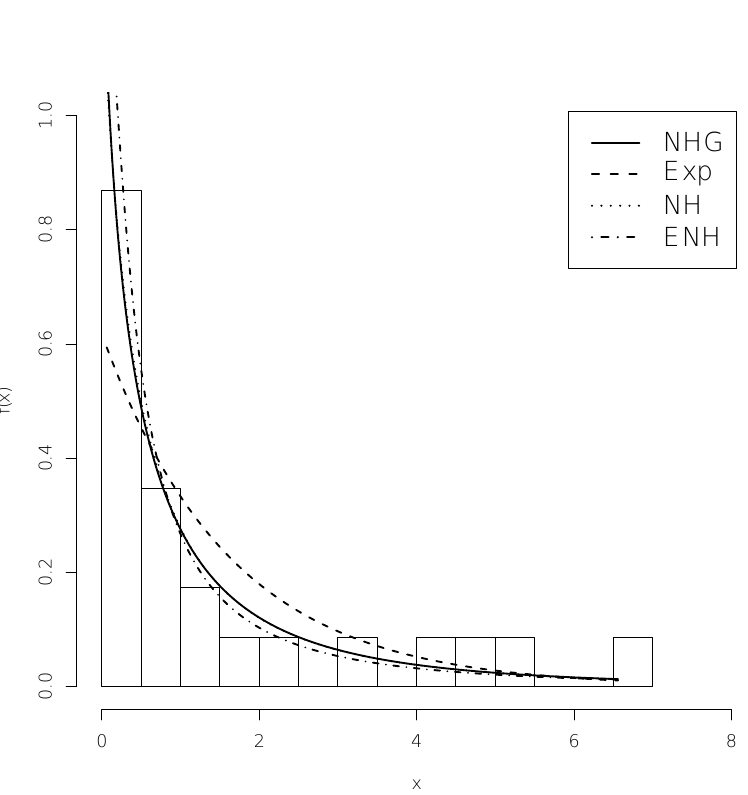
Figure 7 - Estimated for models fitted to the times between failures (thousands of hours) of secondary reactor pumps.